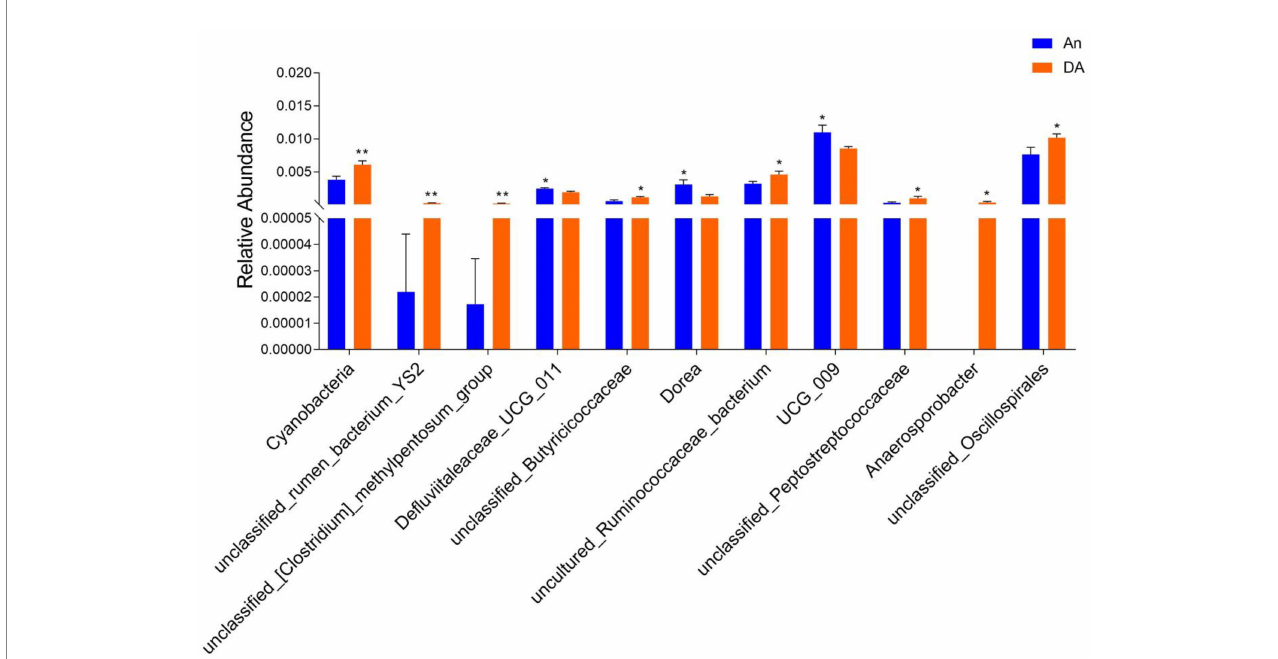
FIGURE 4 Statistical analysis of differential bacteria between An and DA groups at the phylum and genus levels.